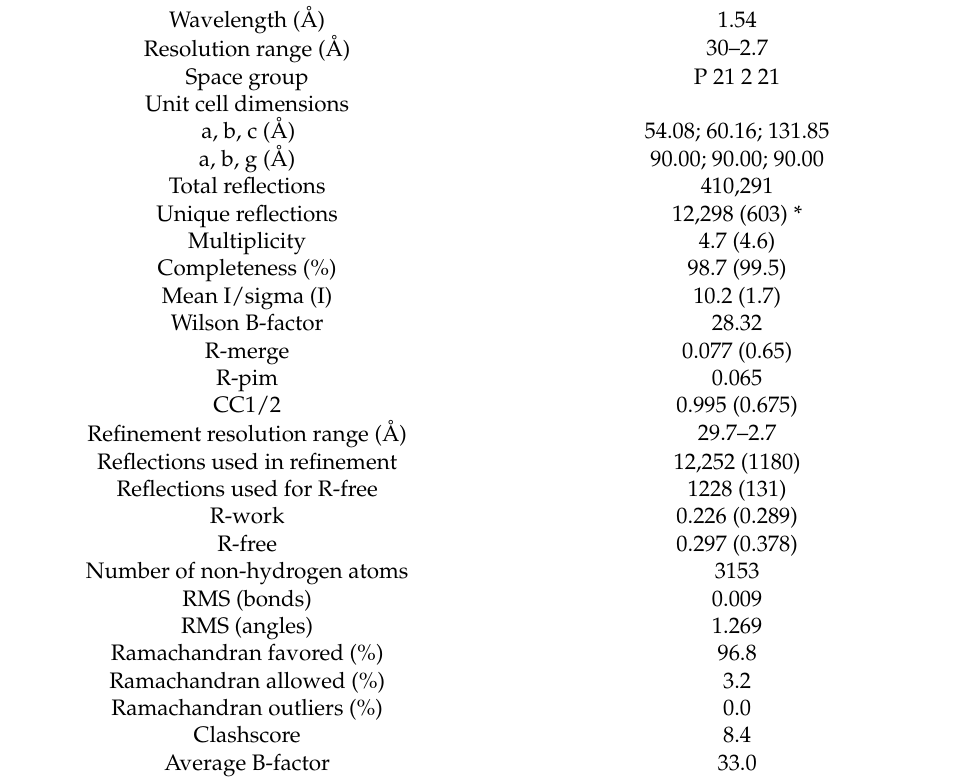
Table 1. Data collection and refinement